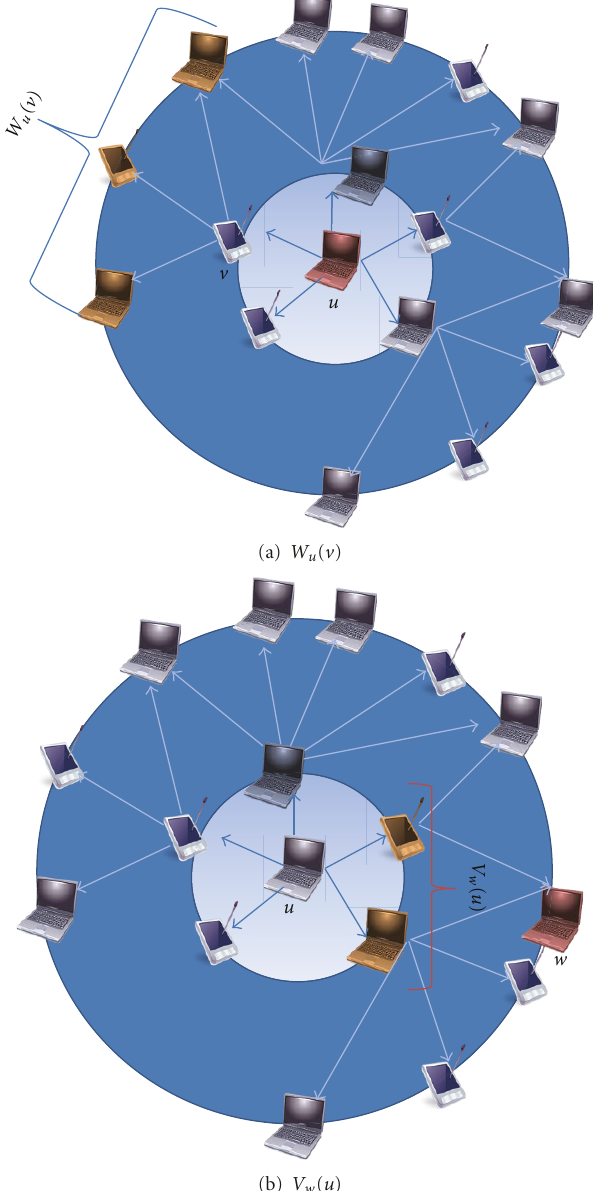
Figure 1: Defining some vertex